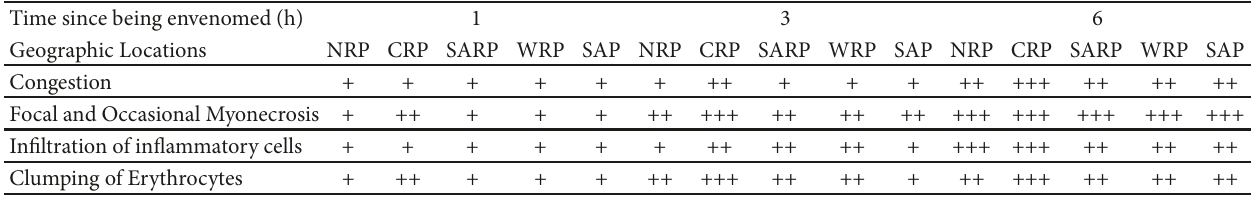
Table 2: Major histopathological changes in cardiac muscles induced by N. naja venom from distinct geographic origins in Sri Lanka. Score: 0: absent; +: mild; ++; moderate; and +++: severe [45]. Time since being envenomed (h)